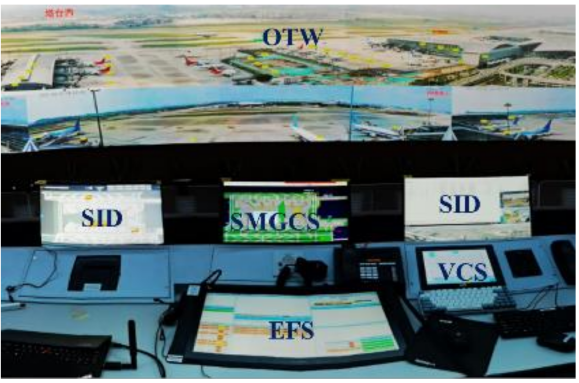
Figure 2. The layout of the digital tower module with a large LED panoramic